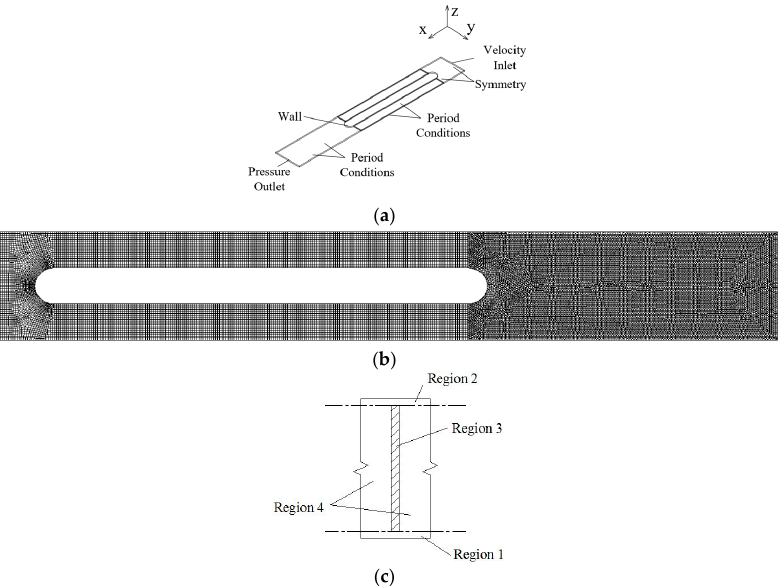
Figure 2. ( a ) Computational domain of the finned flat tube; ( b ) Schematic of mesh; ( c ) The side view of finned flat tube.